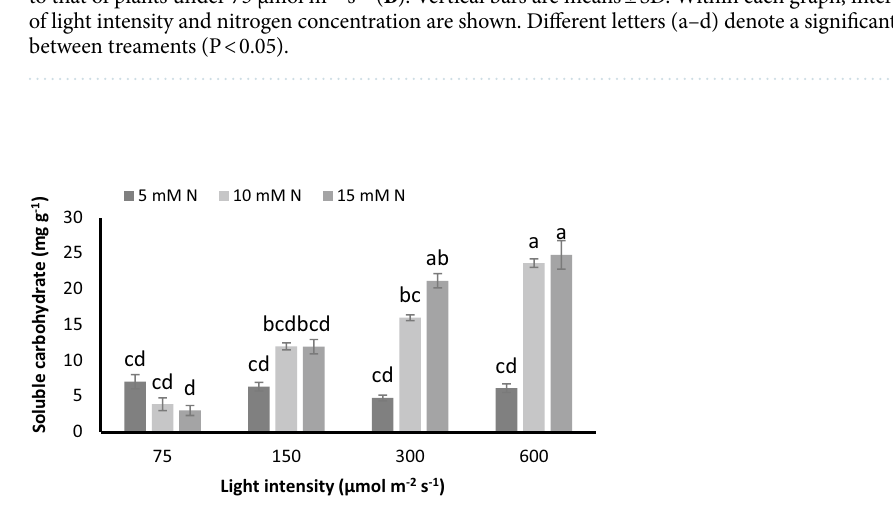
Figure 7. Water soluble carbohydrates (WSC) of chrysanthemum plants grown under different light intensits (75, 150, 300, and 600 µmol m −2 s −1 ) and nitrogen (N) concentrations (5, 10, and 15 mM N) at 70 days of cultivation. Vertical bars are means ± SD. Within each graph, interactive effects of light intensity and nitrogen concentration are shown. Different letters (a–d) denote a significant difference between treaments (P <